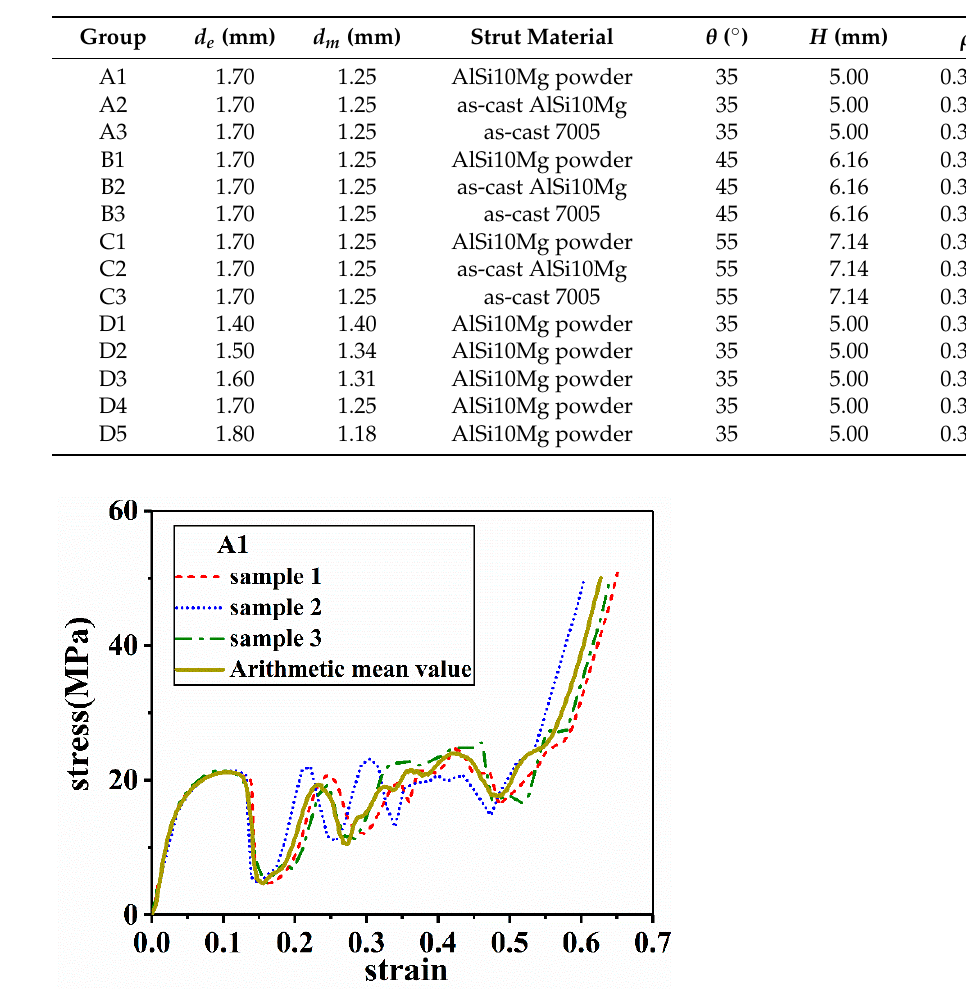
Figure 2. Characteristics of pyramidal lattice structures in the present study: the left is usual and the right is enhanced. Table 1. Parameters of lattice structures.